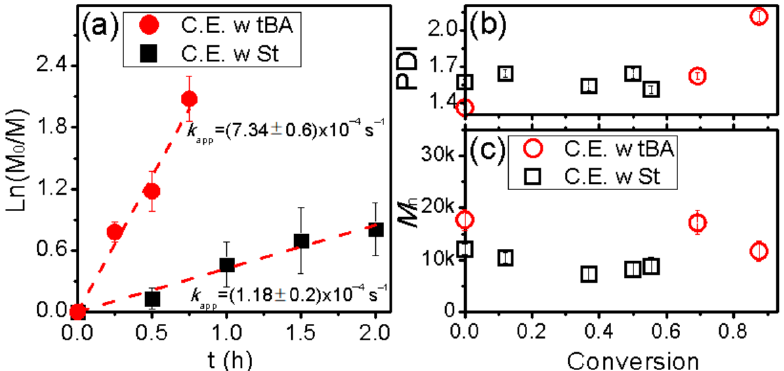
Figure 4. Chain extensions of (PSt) 4 and (PtBA) 4 homo-star MIs with tBA and St, respectively, via bulk NMP at 125 °C: ( a ) Kinetic and ( b , c ) M n , PDI vs. conversion plots (M/MI = 80/1). As shown in routes III(ii) and IV(ii) in Scheme 2, we further conducted hydrolysis of the PtBA segments in µ -star copolymers via TFA. Figure 6A,B represent 1 H NMR spectra (400 MHz, CDCl 3 ) of the original (PSt) 2 - µ -(PtBA- b -PSt) 2 and (PtBA) 2 - µ -(PSt- b - PtBA) 2 µ -star copolymers. These two spectra have similar peaks, including aromatics (i.e., peak Ar) and alkyls (i.e., peaks a–c), resulting from the chemical structures of PSt and PtBA segments. Figure 6C,D represent 1 H NMR spectra (400 MHz, DMSO- d 6 ) of the products that were obtained after the hydrolysis reactions were completed. These two spectra are also similar, including aromatics (i.e., peak Ar), alkyls (i.e., peaks a and b), and acid (i.e., peak c’), revealing our successful deprotection of the tert -butyl group (tBu); the PSt segments remained. We thus acquired (PSt) 2 - µ -(PAA- b -PSt) 2 and (PAA) 2 - µ -(PSt- b -PAA) 2 amphiphilic µ -star